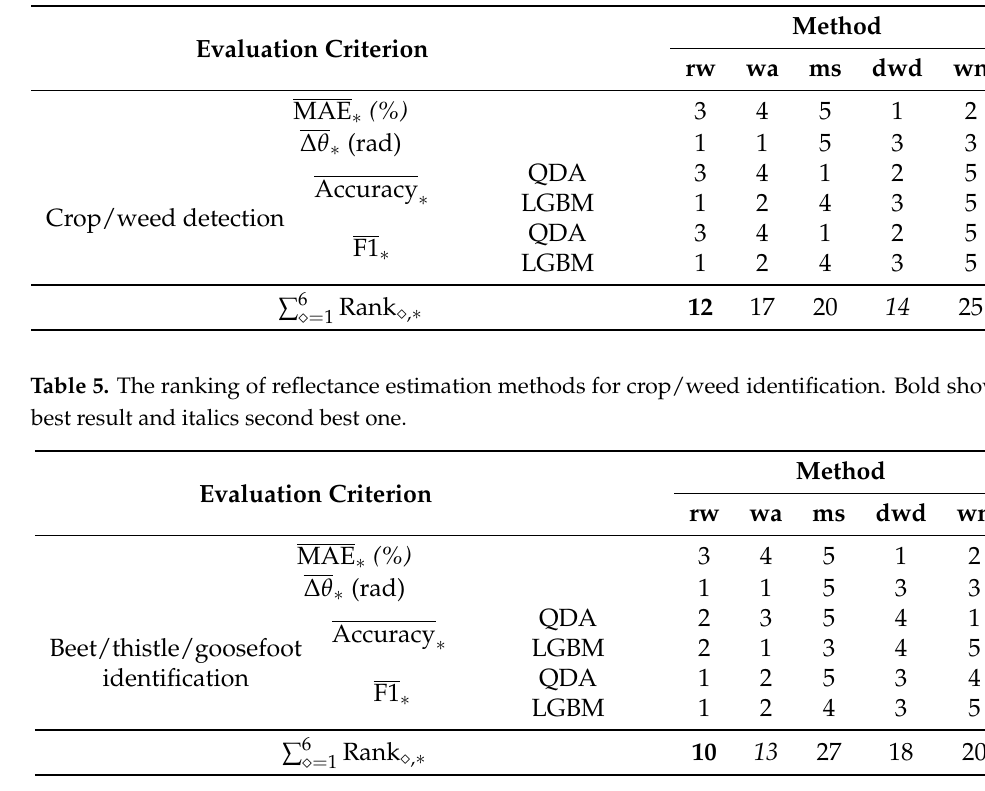
Table 4. The ranking of reflectance estimation methods for crop/weed detection. Bold shows best result and italics second best one.